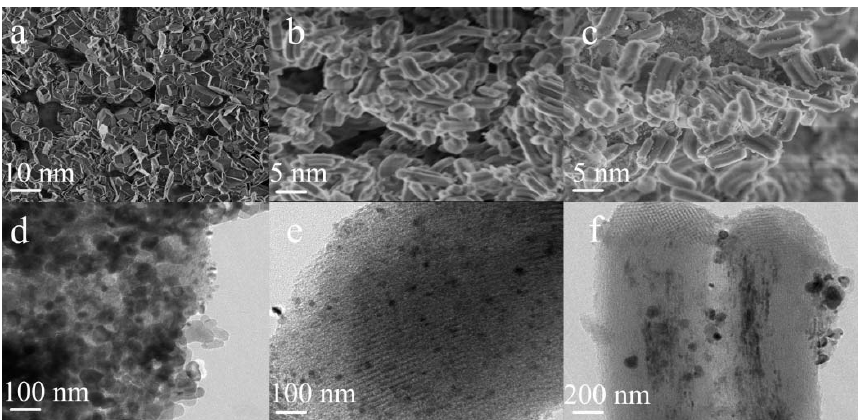
Figure 3. ( a ) SEM images of HZSM-5; ( b ) SEM images SBA-15; ( c ) SEM images Ni-HZSM-5/SBA-15; ( d ) TEM images of Ni/HZM-5; ( e ) TEM images of Ni/SBA-15; ( f ) TEM images of